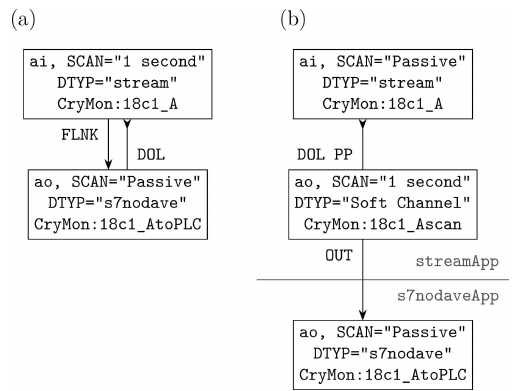
Figure 7 A requirement implemented with ( a ) multi-device and ( b ) single-device IOC applications; for reliability reasons, the latter should be run on the same computer, and be started/stopped as a